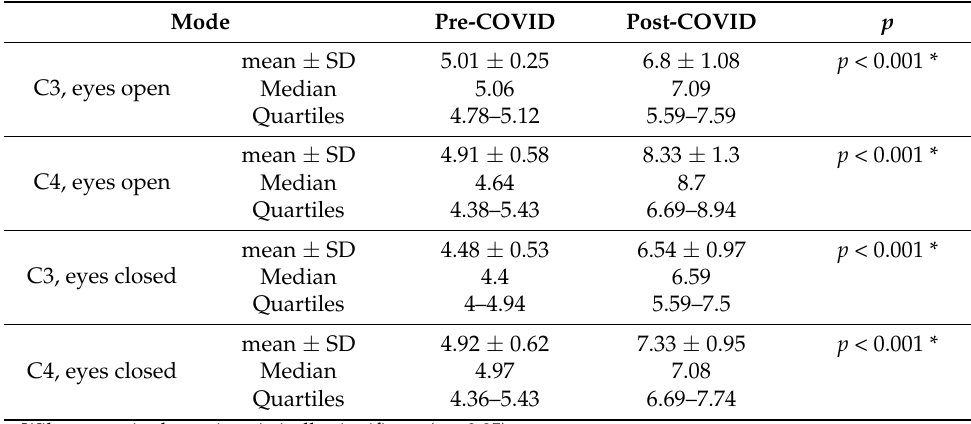
Table 6. The results of the Beta 2 waves examination (waves from C3, C4